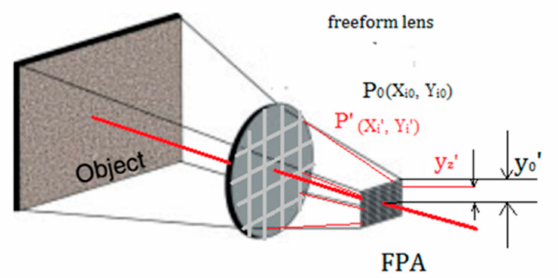
Figure 1. The Schematic diagram of freeform lens changes the direction of the ray light.